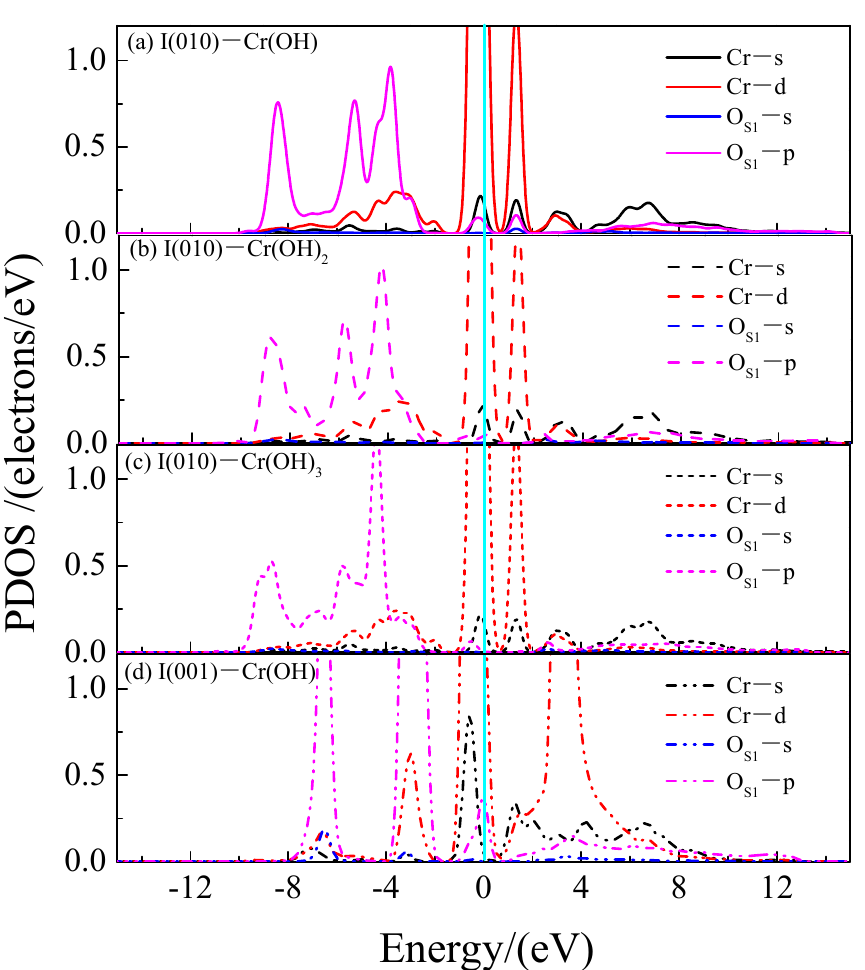
Figure 5. Cr(OH) n(3 − n)+ PDOSs of surface O S1 and Cr: ( a ) I(010)–Cr(OH), ( b ) I(010)–Cr(OH) 2 , ( c ) I(010)–Cr(OH) 3 , and ( d ) I(001)–Cr(OH).